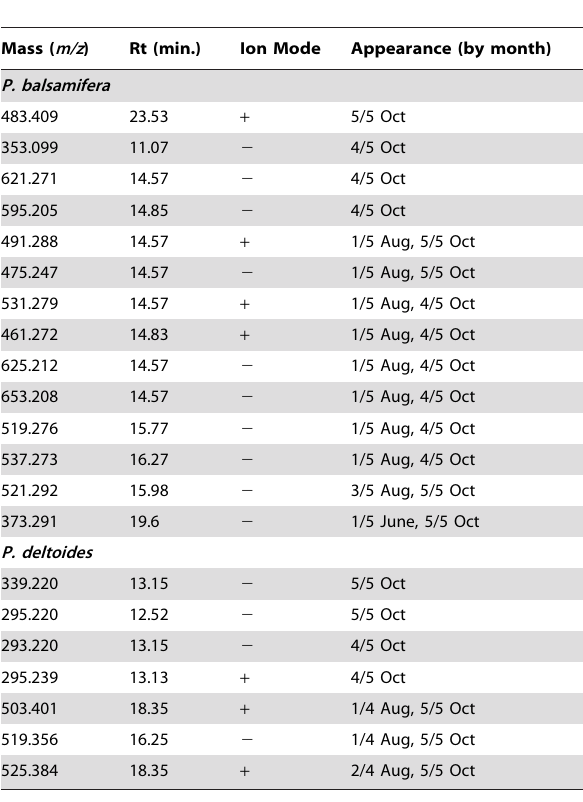
Figure 8. Seasonal variation in P.deltoides . PCA scores plot of resin ‘fingerprints’ from P. deltoides plants collected throughout the growing season. 40.86% of the total variation in the data set is shown. N=2 individuals in May, N=5 individuals in June, N=9 individuals in July (from near Jamestown, ND), N=5 individuals in August, N= 5 individuals in October.